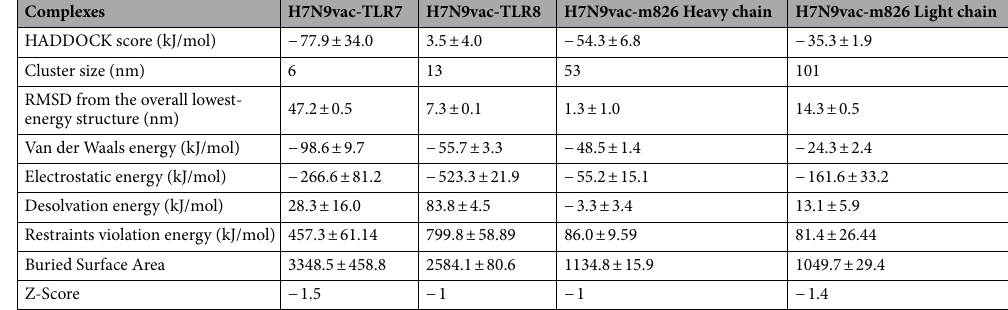
Table 5. HADDOCK clusters results related to H7N9vac-TLR7, H7N9vac-TLR8, H7N9vac-m826 Heavy chain and H7N9vac-m826 Light chain docked complexes. The most reliable cluster was selected based HADDOCK score for each